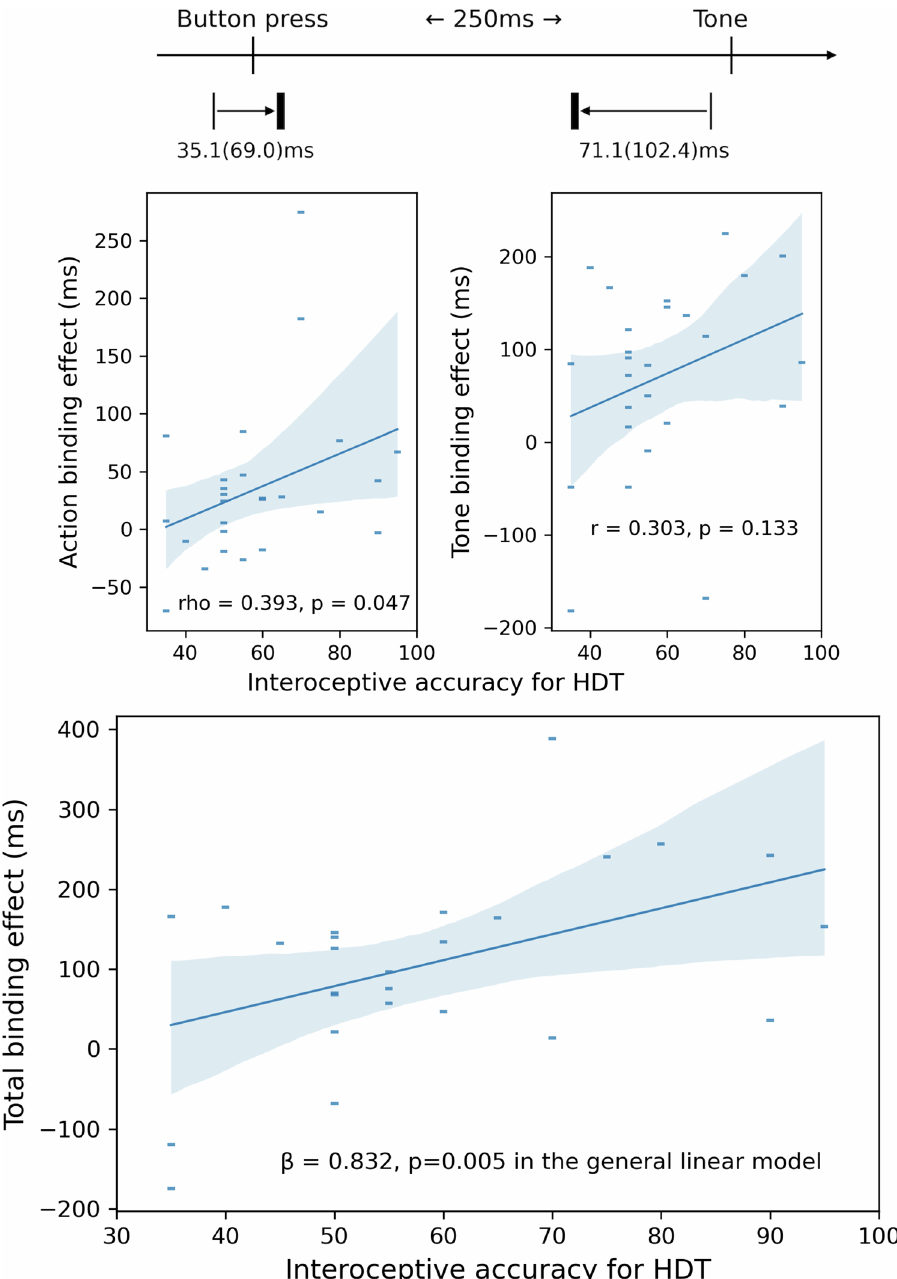
Figure 1. Total intentional binding effect was significantly predicted by interoceptive accuracy for HDT (β = 0.832, p =